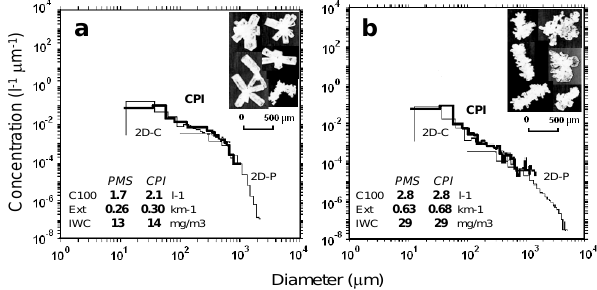
Fig. A1. Mean particle size distributions measured by the 2D-C, 2D-P and the CPI probes obtained during the POLARCAT experi- ment in a Nimbostratus cloud near − 25 ◦ C (a) and a boundary layer mixed-phase cloud near − 15 ◦ C (b) , respectively. Mean values of the concentration of particles with D> 100 µ m, extinction coeffi- cient and ice water content are also